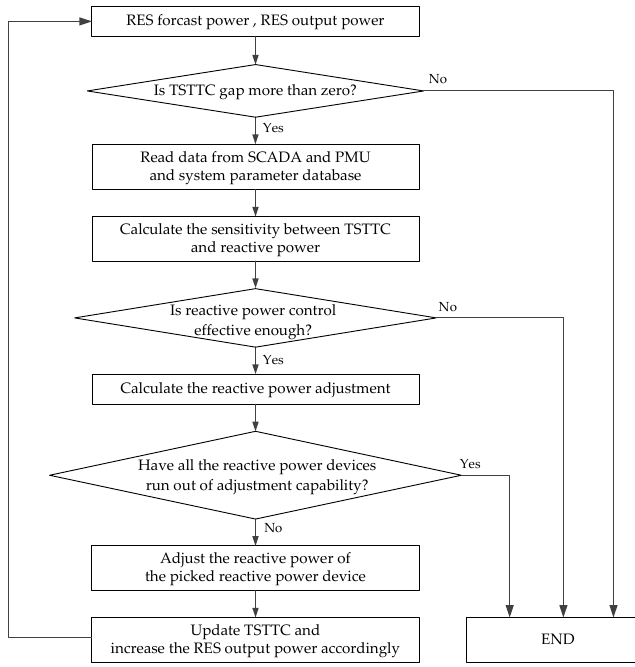
Figure 4. Flow diagram of the reactive power control method.